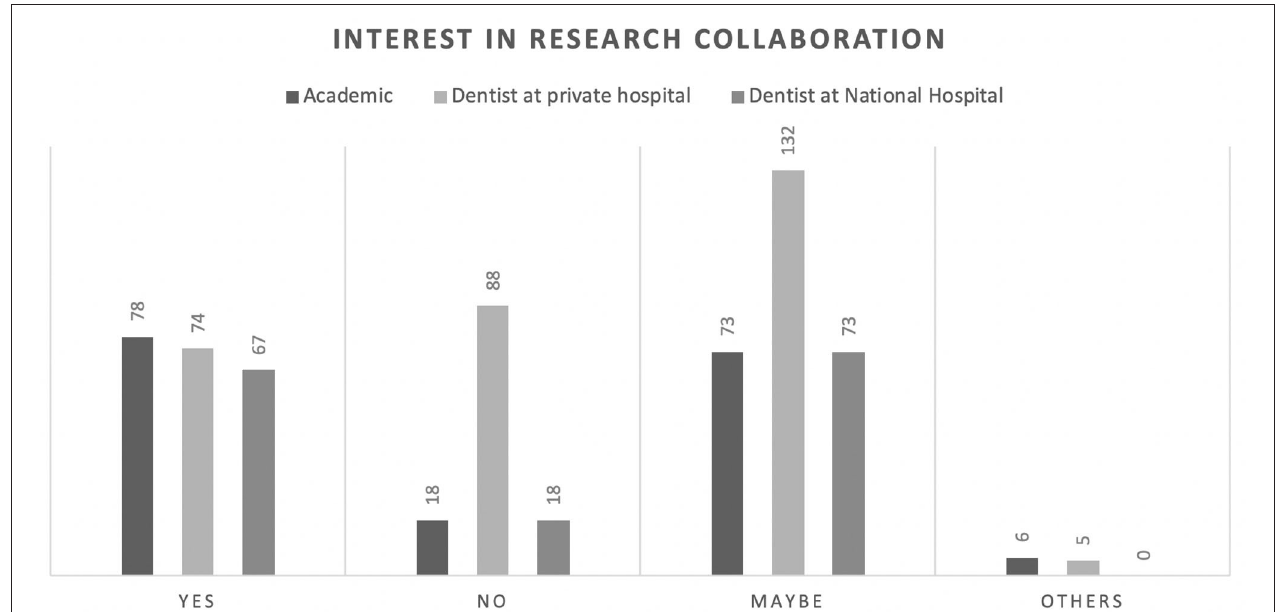
FIGURE 7 | Respondents from dental faculties were more interested in research collaboration with governmental institutions ( p <